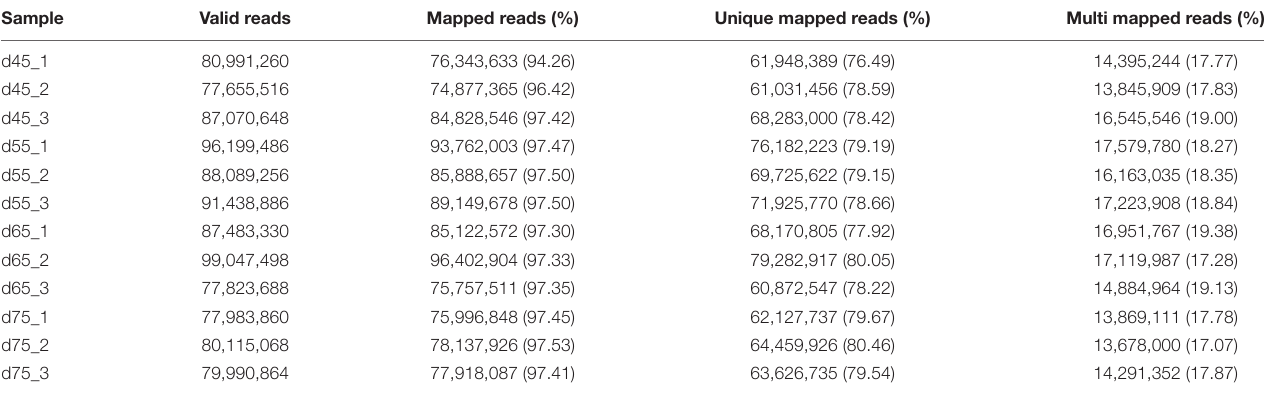
TABLE 2 | Reference genome alignment read statistics.